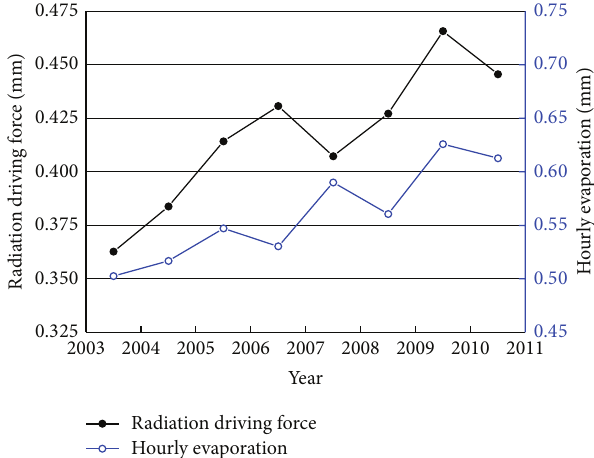
Figure 7: The variation trends of annual mean of 1-hour (13:10– 14:10) radiation driving force and hourly evaporation in Dongping Lake during 2003–2010 (open circle means hourly evaporation, dot means radiation driving force).